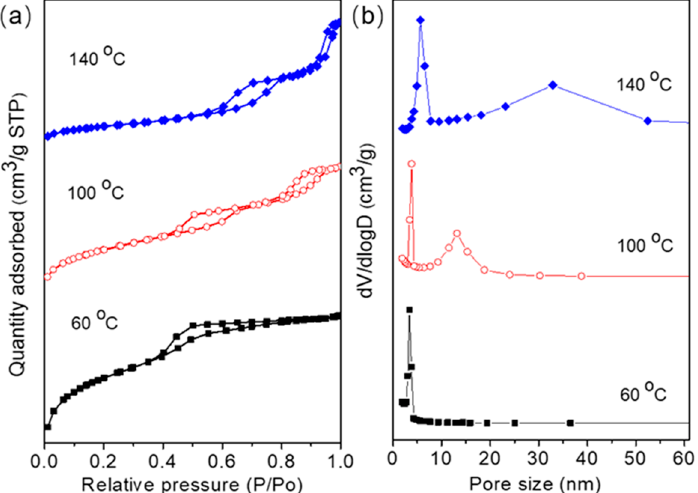
Figure 2. N 2 ‐ BET ( a ) and pore size distribution ( b ) curves of HMS materials (Entry No.4) synthesized under different hydrothermal temperature.